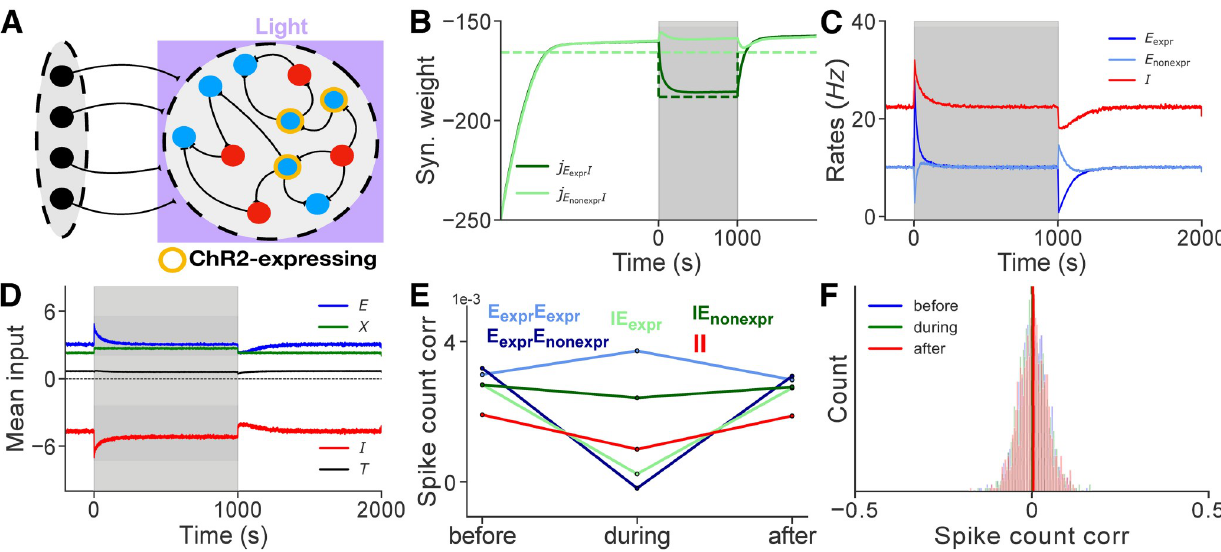
Fig 4. Framework for STDP in balanced networks describes the dynamics of networks receiving optogenetic input. A : A recurrent network of excitatory, E , and inhibitory, I , neurons is driven by an external feedforward layer X 1 of uncorrelated Poisson neurons. Neurons that express ChR2 are driven by optogenetic input, which is modeled as an extra layer of Poisson neurons denoted by X 2 . B : Evolution of mean synaptic weights over the course of the experiment. C : Evolution of mean firing rates. Inhibitory STDP maintains E rates near the target, a e . D : Evolution of mean excitatory, external, 2 t STDP inhibitory, and total currents. Balance is transiently disrupted at stimulus onset and offset, but it is quickly restored by iSTDP. E : Mean spike count correlations before, during, and after stimulation remain very weak for all pairs. F : The distribution of spike count correlations also remains nearly unchanged with weak mean correlations before, during, and after stimulation. Solid lines represent simulations, dashed lines are values obtained from theory (Eqs (3), (5), (27) and (28)).